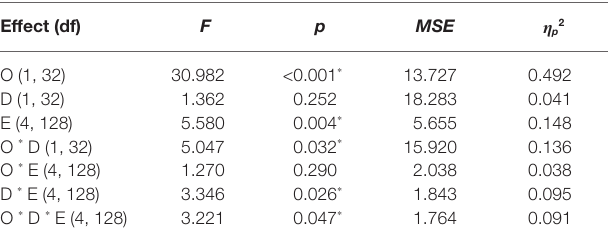
TABLE 2 | F -values for midline analyses of Object and Determiner type at critical word for time window 300–500 ms.